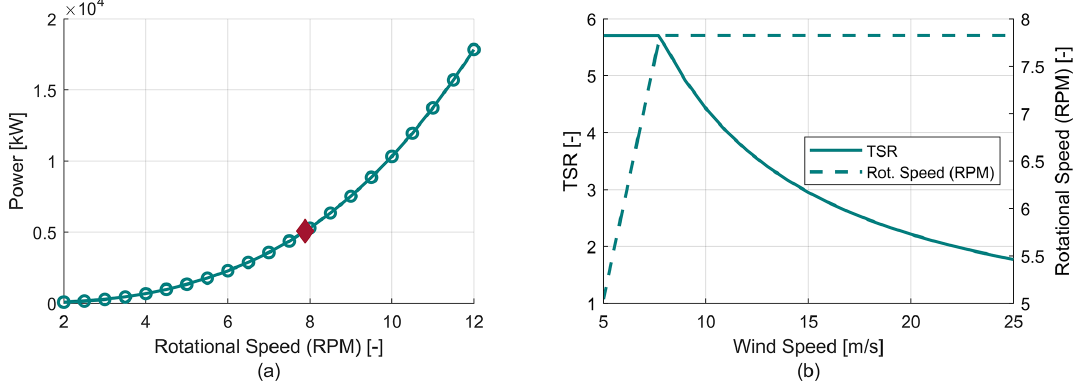
Figure 5. Stage 2 and 3 of the operational strategy development. (a) RPM sweep at stall TSR (stage 2). (b) Rotor speed schedule example (stage